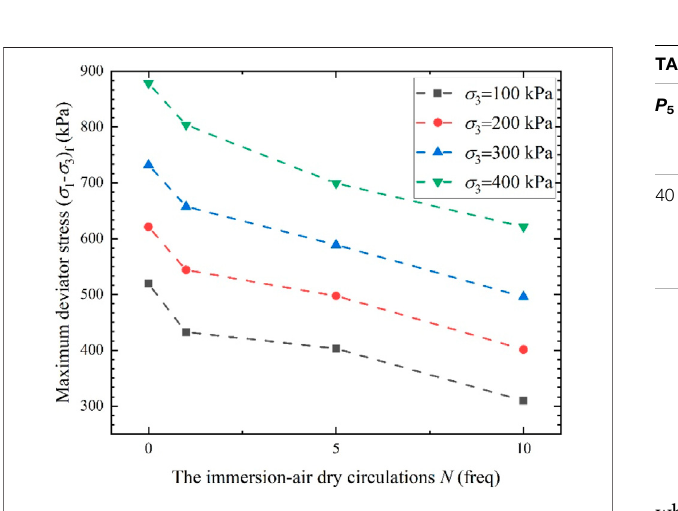
FIGURE 8 | Deterioration trend of S-RMs.